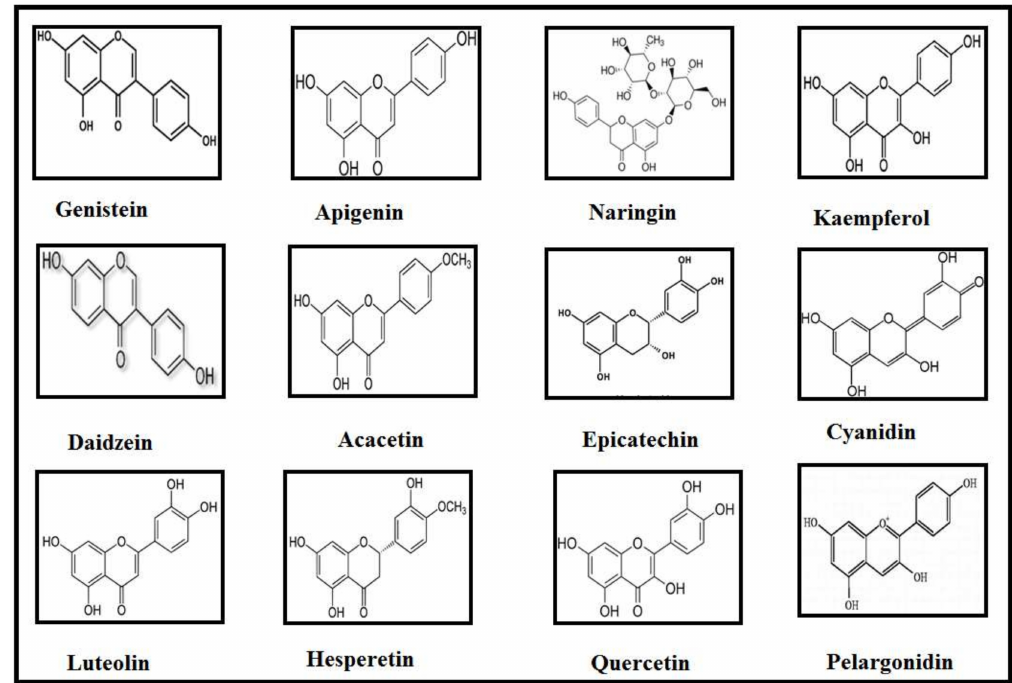
Figure 1. Structures of compounds that discussed in this review.